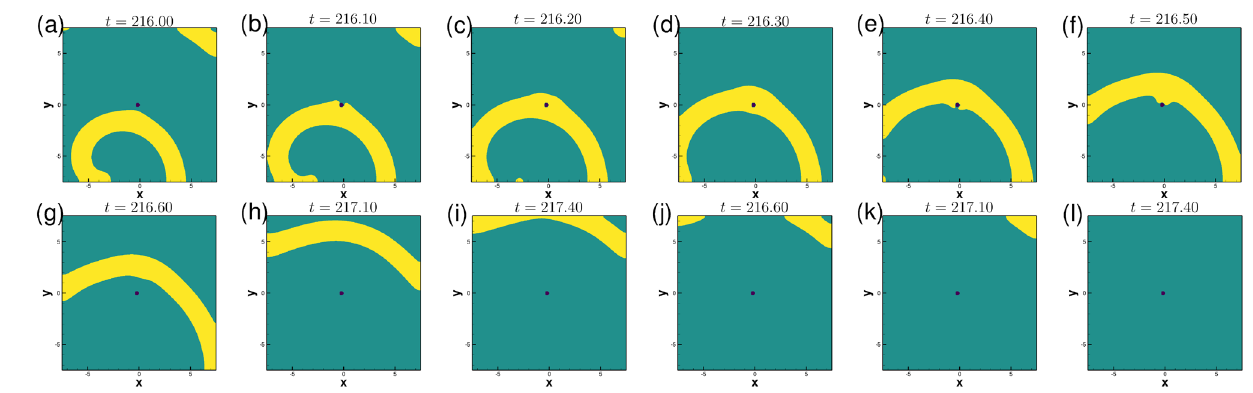
Figure 13. Spiral wave pattern evolutions for γ = − 0.01 , with a circular obstacle (blue spot), showing the eventual elimination of spiral wave from computational